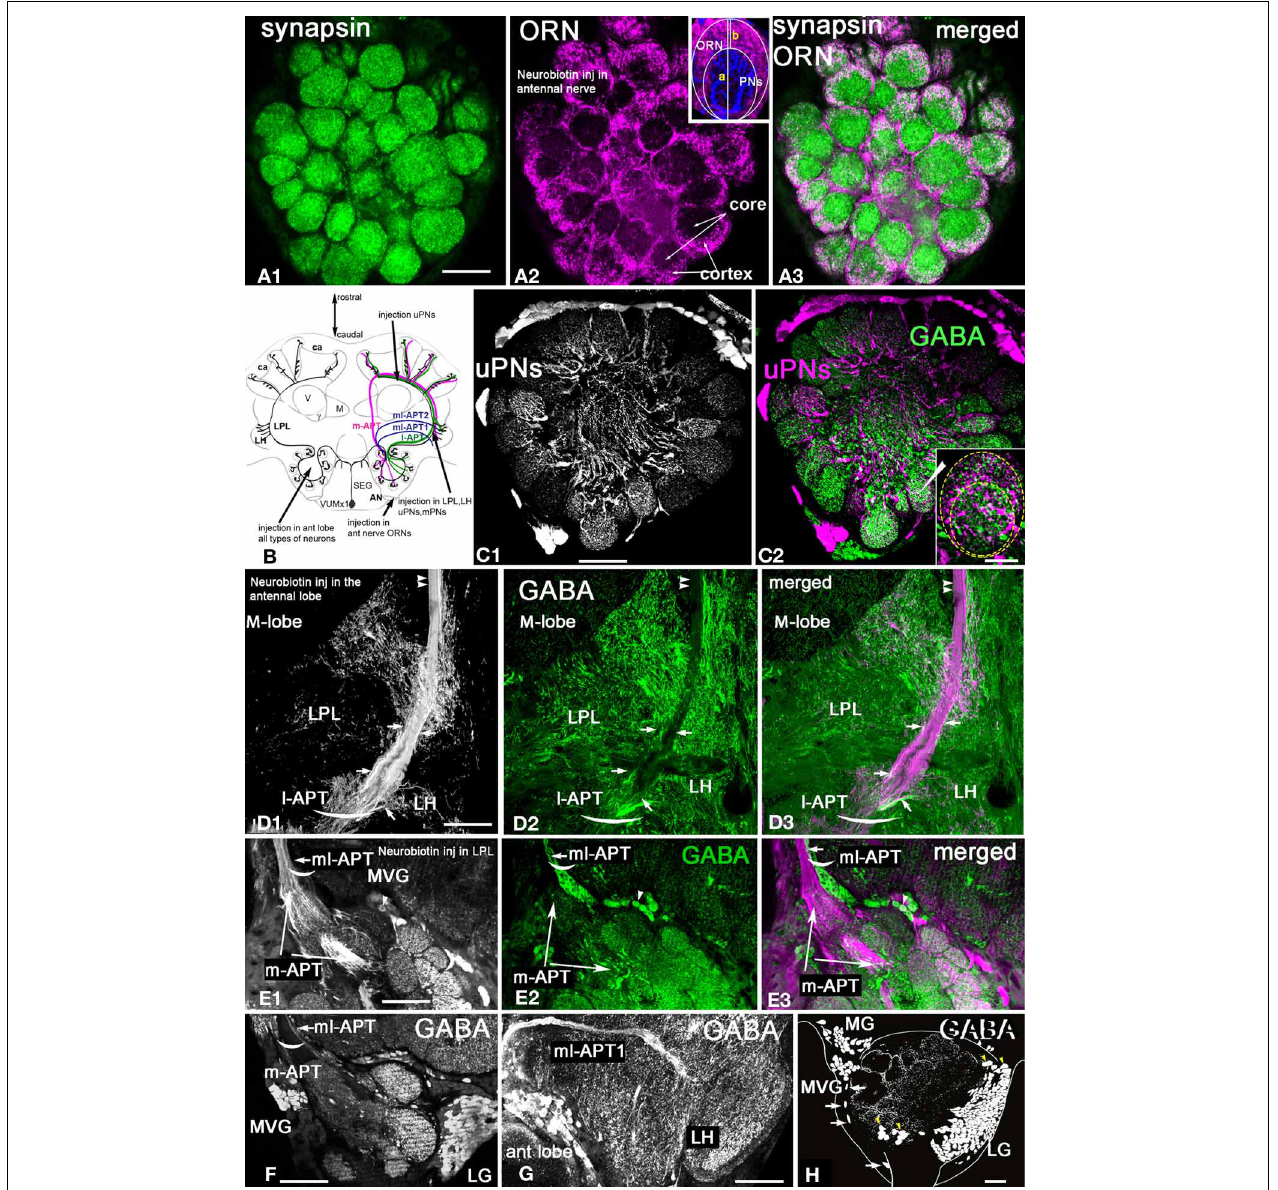
FIGURE 2 | Apis mellifera . General morphology of the antennal lobe and glomerulus. GABAergic neurons in the honeybee antennal lobe are local interneurons and multiglomerular PNs that branch into LPL and LP. (A) Frontal section of the honeybee antennal lobe immunostained with anti-synapsin antibodies (green) and Rhodamine-dextran labeled olfactory receptors neurons (magenta). (A1) Anti-synapsin (green) shapes the synaptic neuropil of the antennal lobe in all glomeruli, highlighting the potential synaptic connections between different types of neurons. (A2) Rhodamine-dextran injection into the antennal nerve revealed olfactory receptor neuron (ORN) endings (magenta) surrounding each glomerulus to form the cortex layer. The core area of glomerulus is free of ORNs. (A3) The merged images of the cortex area of the ORN endings in the antennal lobe overlapped with the area marked by anti-synapsin (white) indicate that ORNs synapse and receive synapses from other antennal lobe neurons in the cortex rind of glomerulus. Insert in (A2) : The schematic of the glomerulus overlaid on the middle section indicated by the image of the projection neuron dendrite (blue, PNs)